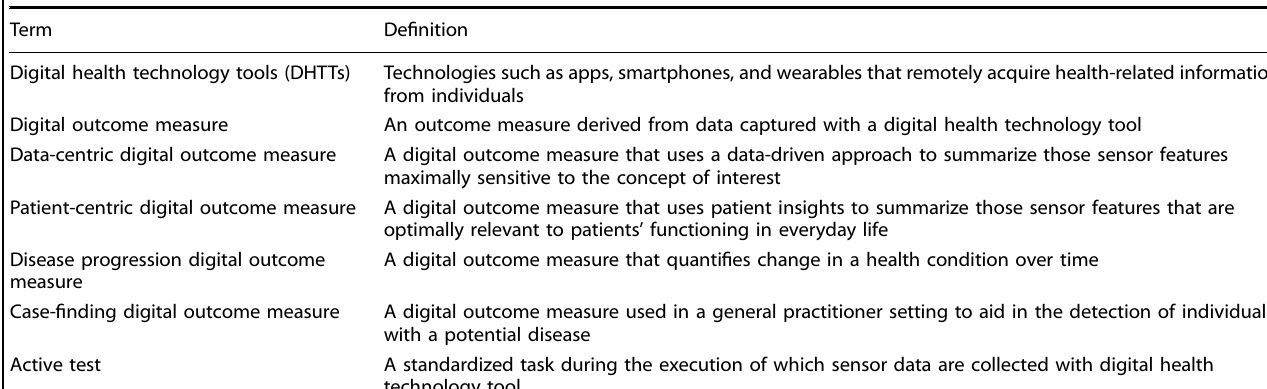
Table 1. Terms and de fi nitions.